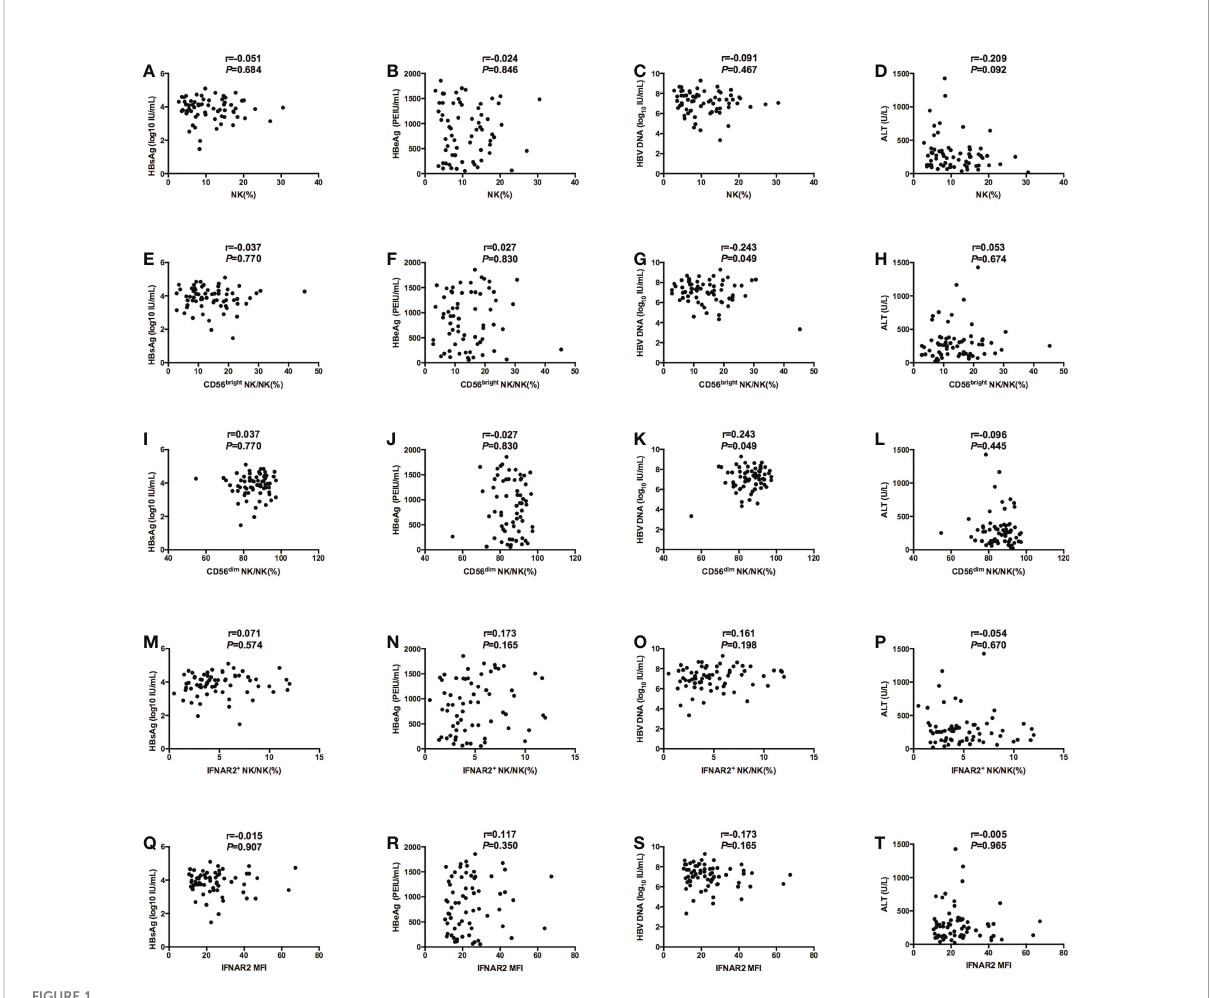
FIGURE 1 Correlations between NK cell frequency or function (NK%, CD56bright NK/NK%, CD56dim NK/NK%, IFNAR2+ NK/NK%, and IFNAR2 MFI) and serological and virological indicators (HBsAg, HBeAg, and HBV DNA, ALT). (A-D) Correlations between NK% and serological and virological indicators (HBsAg (A) , HBeAg (B) , and HBV DNA (C) , ALT (D) ). (E-H) Correlations between CD56bright NK/NK% and serological and virological indicators (HBsAg (E) , HBeAg (F) , and HBV DNA (G) , ALT (H) ). (I-L) Correlations between CD56dim NK/NK% and serological and virological indicators (HBsAg (I) , HBeAg (J) , and HBV DNA (K) , ALT (L) ). (M-P) Correlations between IFNAR2+ NK/NK% and serological and virological indicators (HBsAg (M) , HBeAg (N) , and HBV DNA (O) , ALT (P) ). (Q-T) Correlations between IFNAR2 MFI and serological and virological indicators (HBsAg (Q) , HBeAg (R) , and HBV DNA (S) , ALT (T) ). P < 0.05 was considered to be statistically signi fi